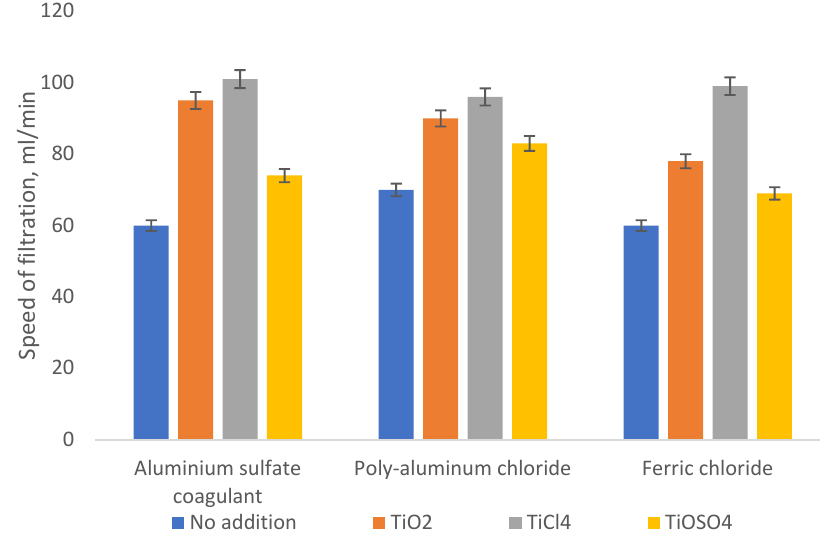
Figure 5. Filtration rate of coagulation sludge of the alcohol industry wastewater. Table 2. Residual concentrations and treatment efficiency.